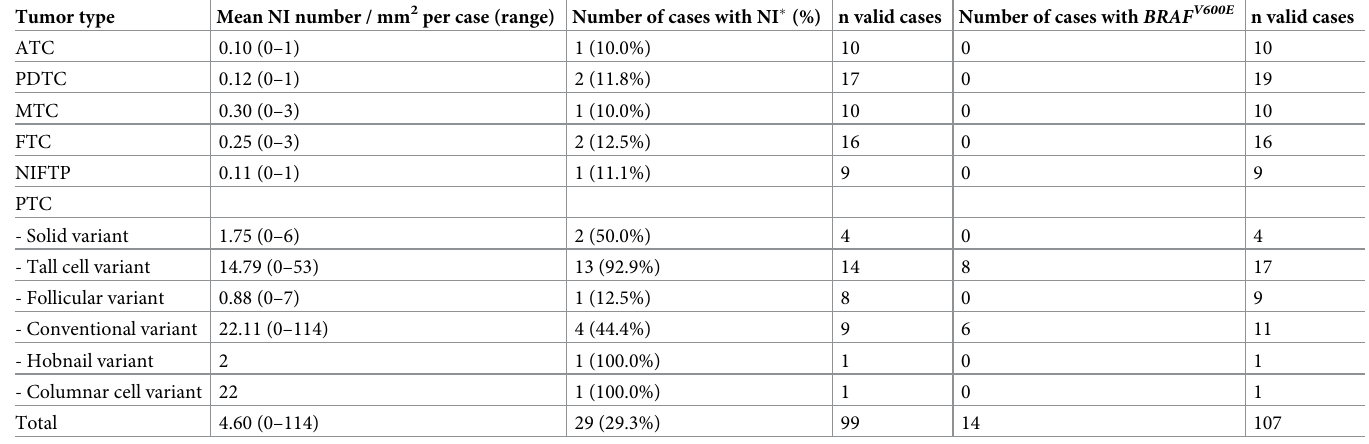
Table 2. Number of NI and cases with BRAF V600E in the thyroid carcinoma cohort. Tumor